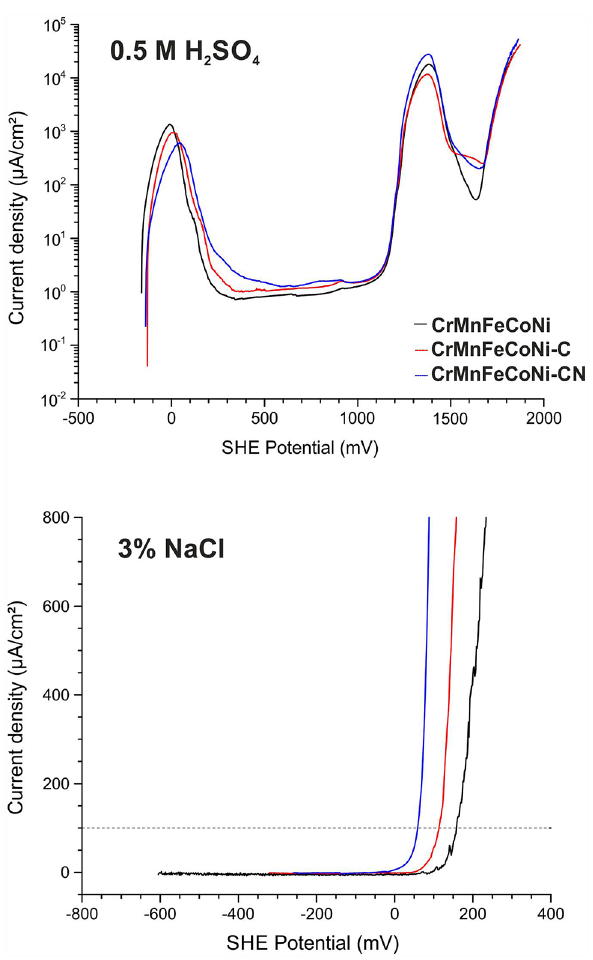
Fig. 5 Current density - potential curves. a) 0.5 M H 2 SO 4 solution. b) and c) 3 wt.-% NaCl